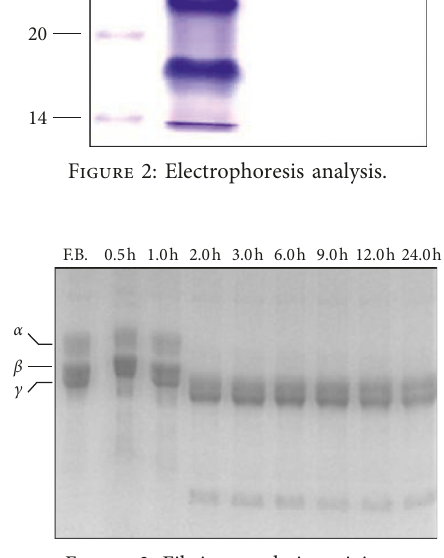
Figure 3: Fibrinogenolytic activity.